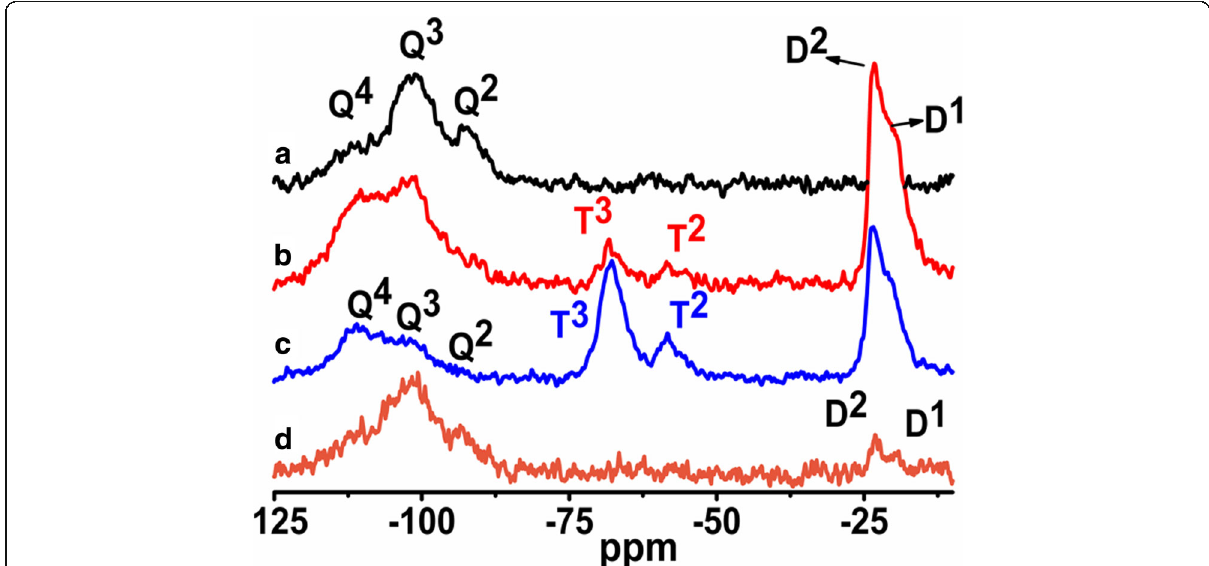
Fig. 7 29 Si CP/MAS NMR spectra of ( a ) neat fumed silica, ( b ) modified fumed silica with PDMS, modified with ( c ) mixtures of PDMS and dimethyl carbonate and ( d ) mixtures of PDMS and diethyl